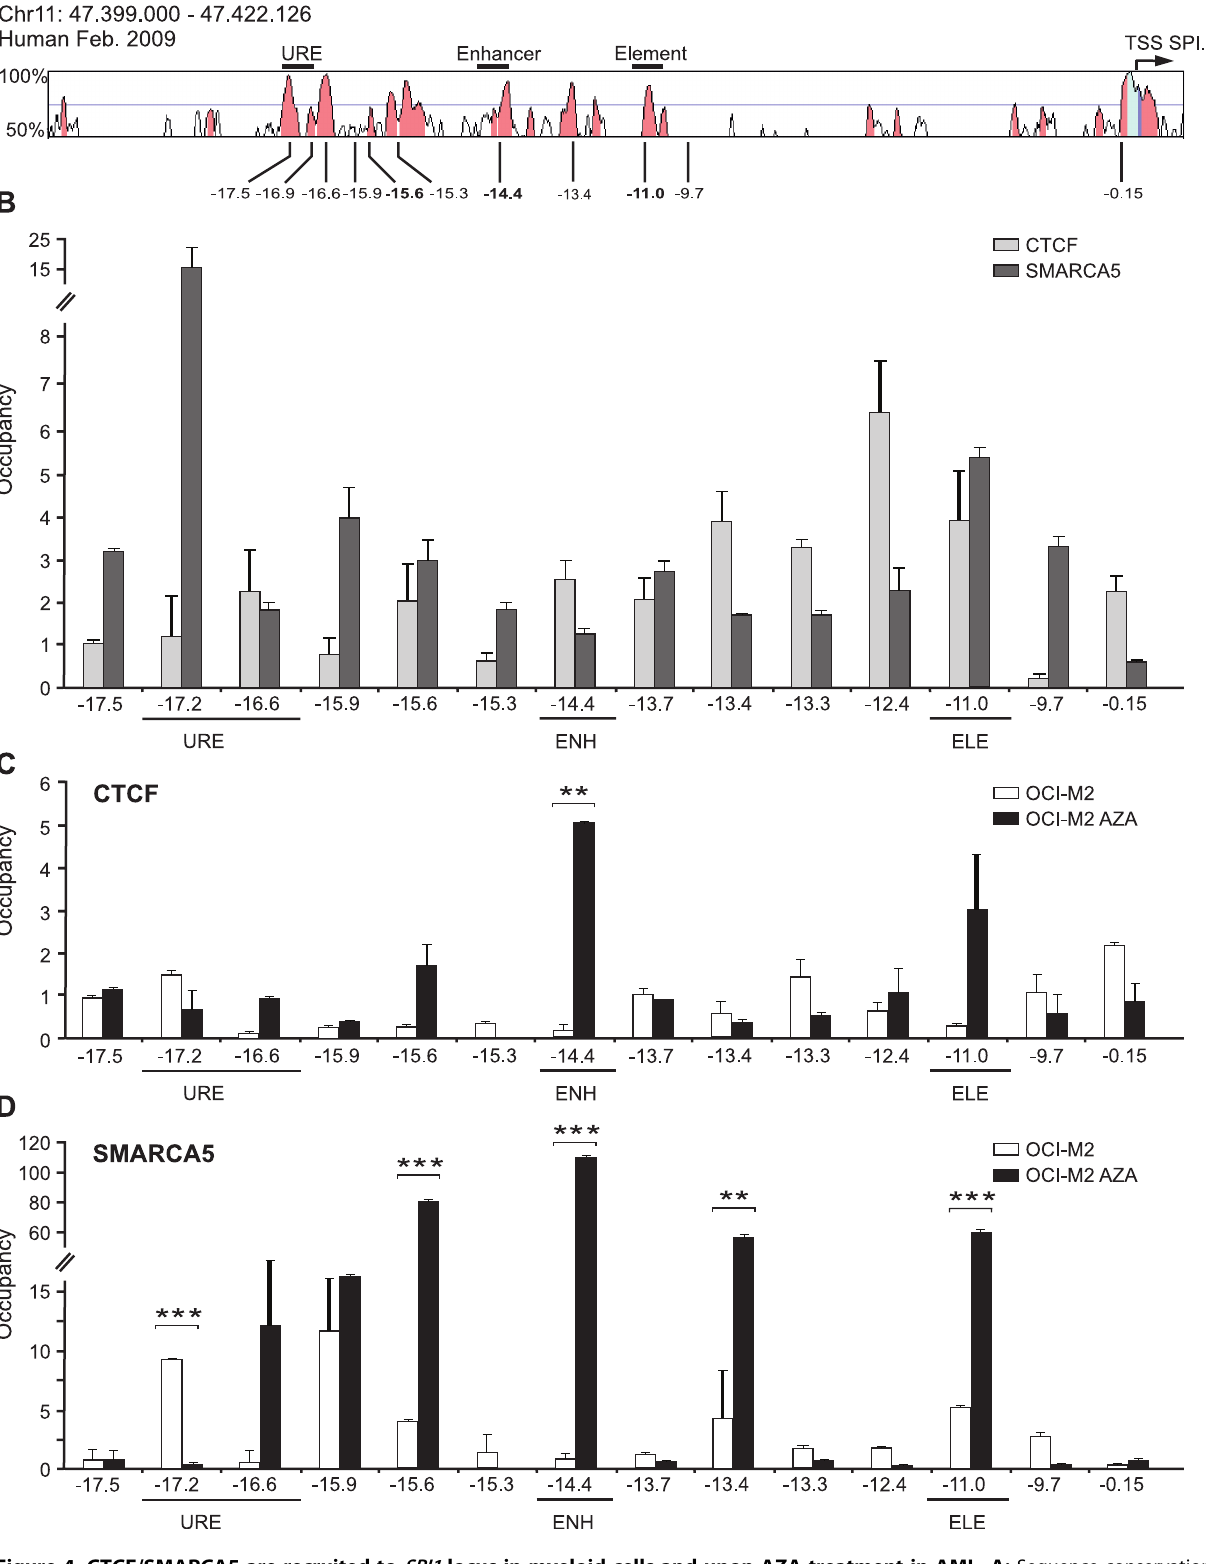
Figure 4. CTCF/SMARCA5 are recruited to SPI1 locus in myeloid cells and upon AZA treatment in AML. A: Sequence conservation of human SPI1 locus (VISTA) generated by aligning with murine DNA. Regulatory regions and positions of ChIP amplicons are numbered in respect to human SPI1 TSS. B: ChIP of CTCF and SMARCA5 in mixed myeloid cells. C: ChIP of CTCF and D: SMARCA5 in OCI-M2 without (OCI-M2) or with AZA